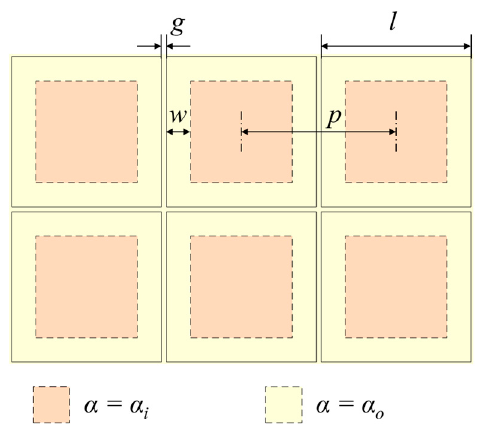
Figure 7. The LCoS pixel layout and optimization parameters: pixel length l , pixel gap g , pixel pitch p , FFE border width w , inner zone pretilt angle α i , and inner zone pretilt angle α o . After basic evaluation, there are two determining methods to optimize the pretilt angle pattern.